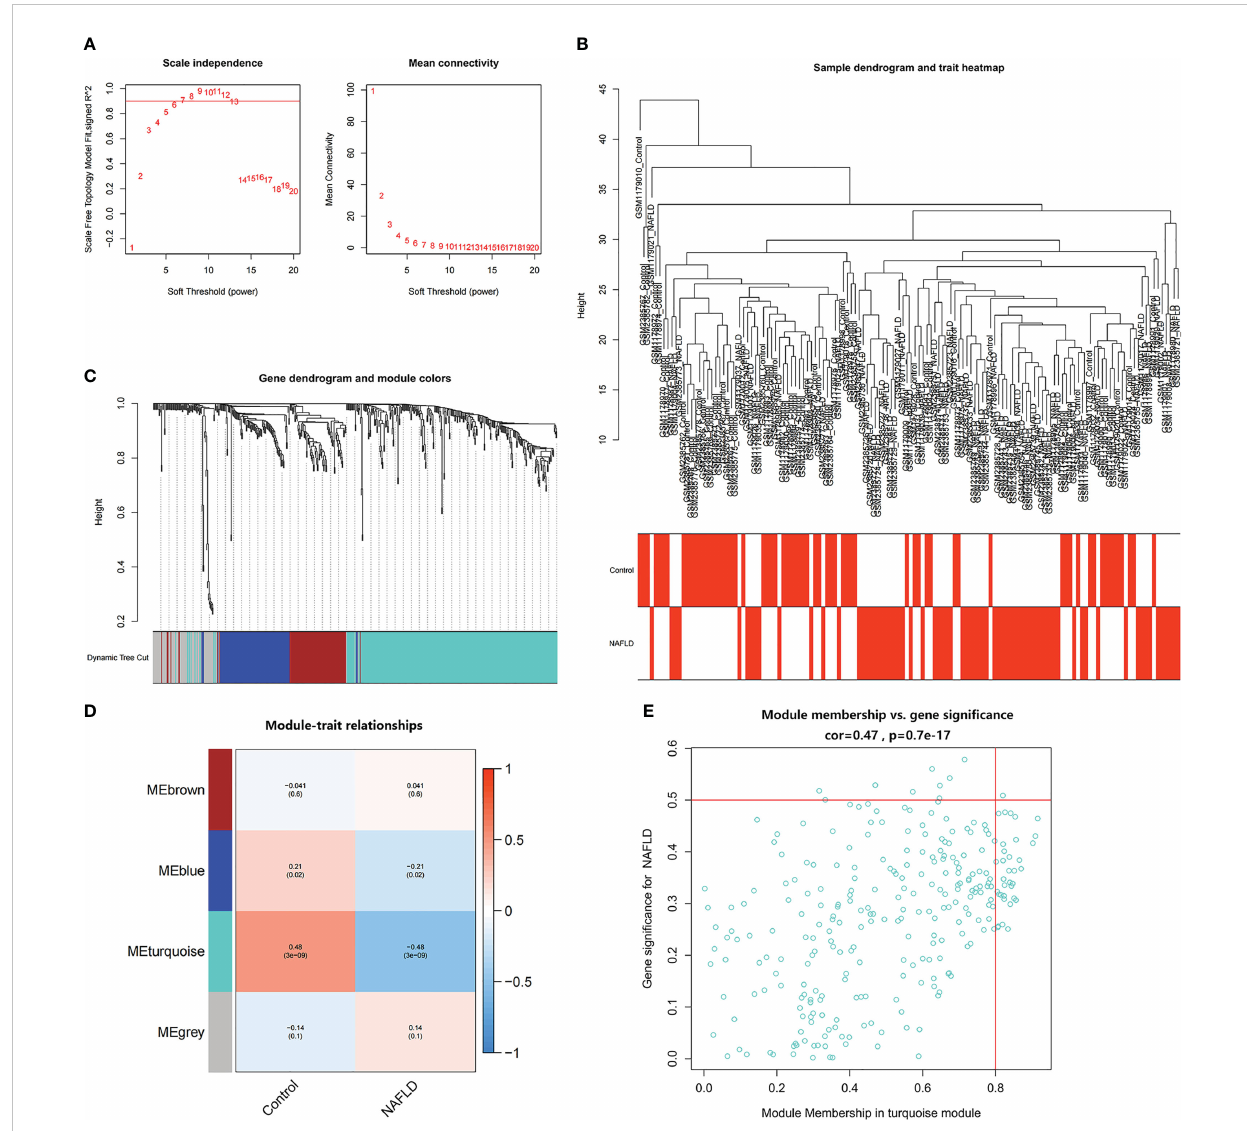
FIGURE 4 Identi fi cation of module genes in NAFLD. (A) The soft threshold ( b ) was determined to be 6 when the correlation coef fi cient was 0.9. (B) Clustering dendrogram of NAFLD and control samples. (C) Each branch in the cluster diagram refers to a gene, and different colors represent a gene co-expression module. (D) Heatmap of module – trait relationships. (E) Scatter plot of the correlation between gene module membership and gene signi fi cance in the turquoise